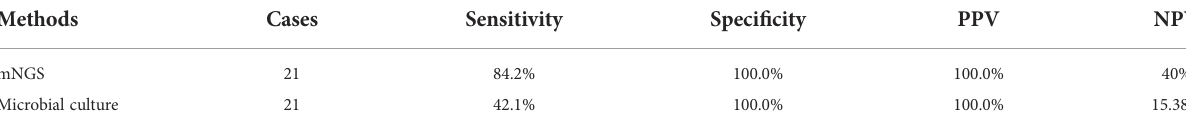
TABLE 3 Comparison of diagnosis performance of mNGS and microbial culture in patients who had pus samples for both methods.